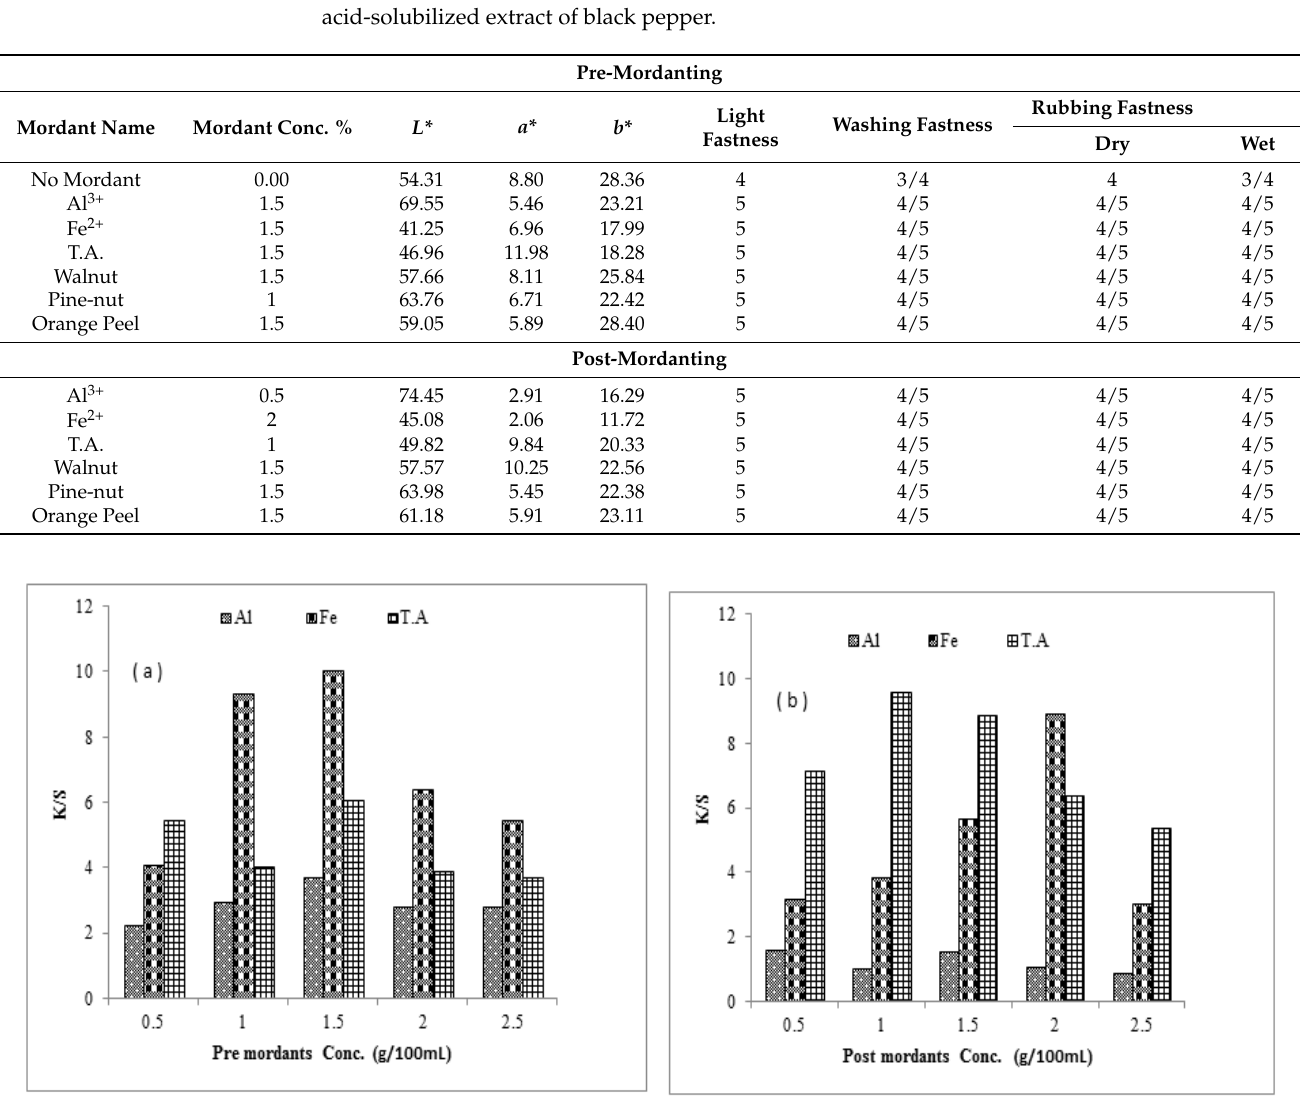
Table 2. Colorfastness ratings of chemical mordant and bio-mordanted silk fabric dyed using an acid-solubilized extract of black pepper.